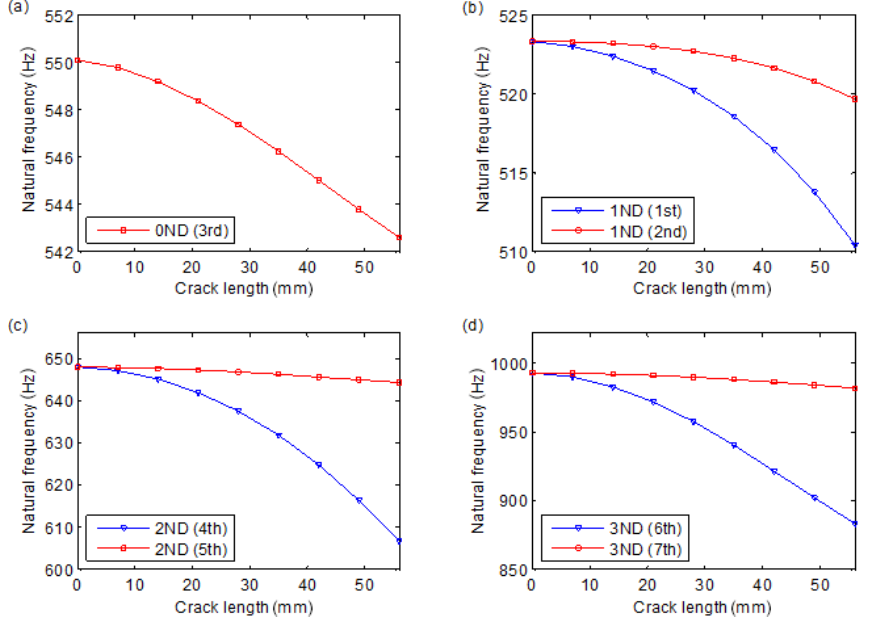
Figure 6. Variation of natural frequencies versus crack length: (a) 0ND, (b) 1ND, (c) 2ND and (d) 3ND. The numbers in brackets denote the order of natural frequencies.